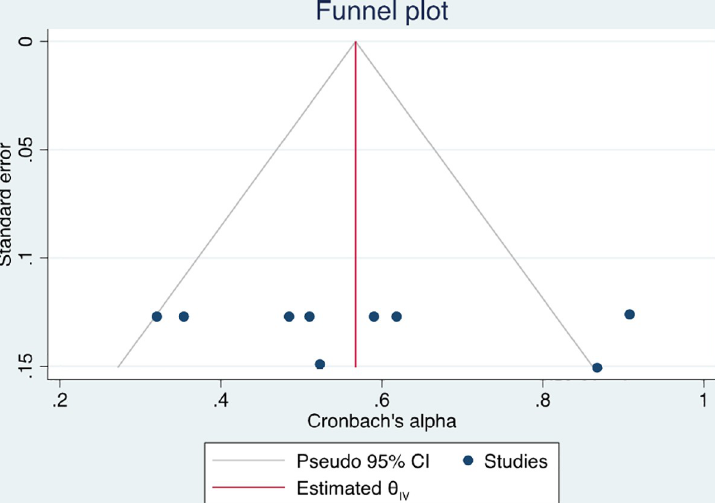
Fig 3. Funnel plot to for publication bias. Funnel plot presenting the studies alpha values from OSCEs, were each circle represents a study.